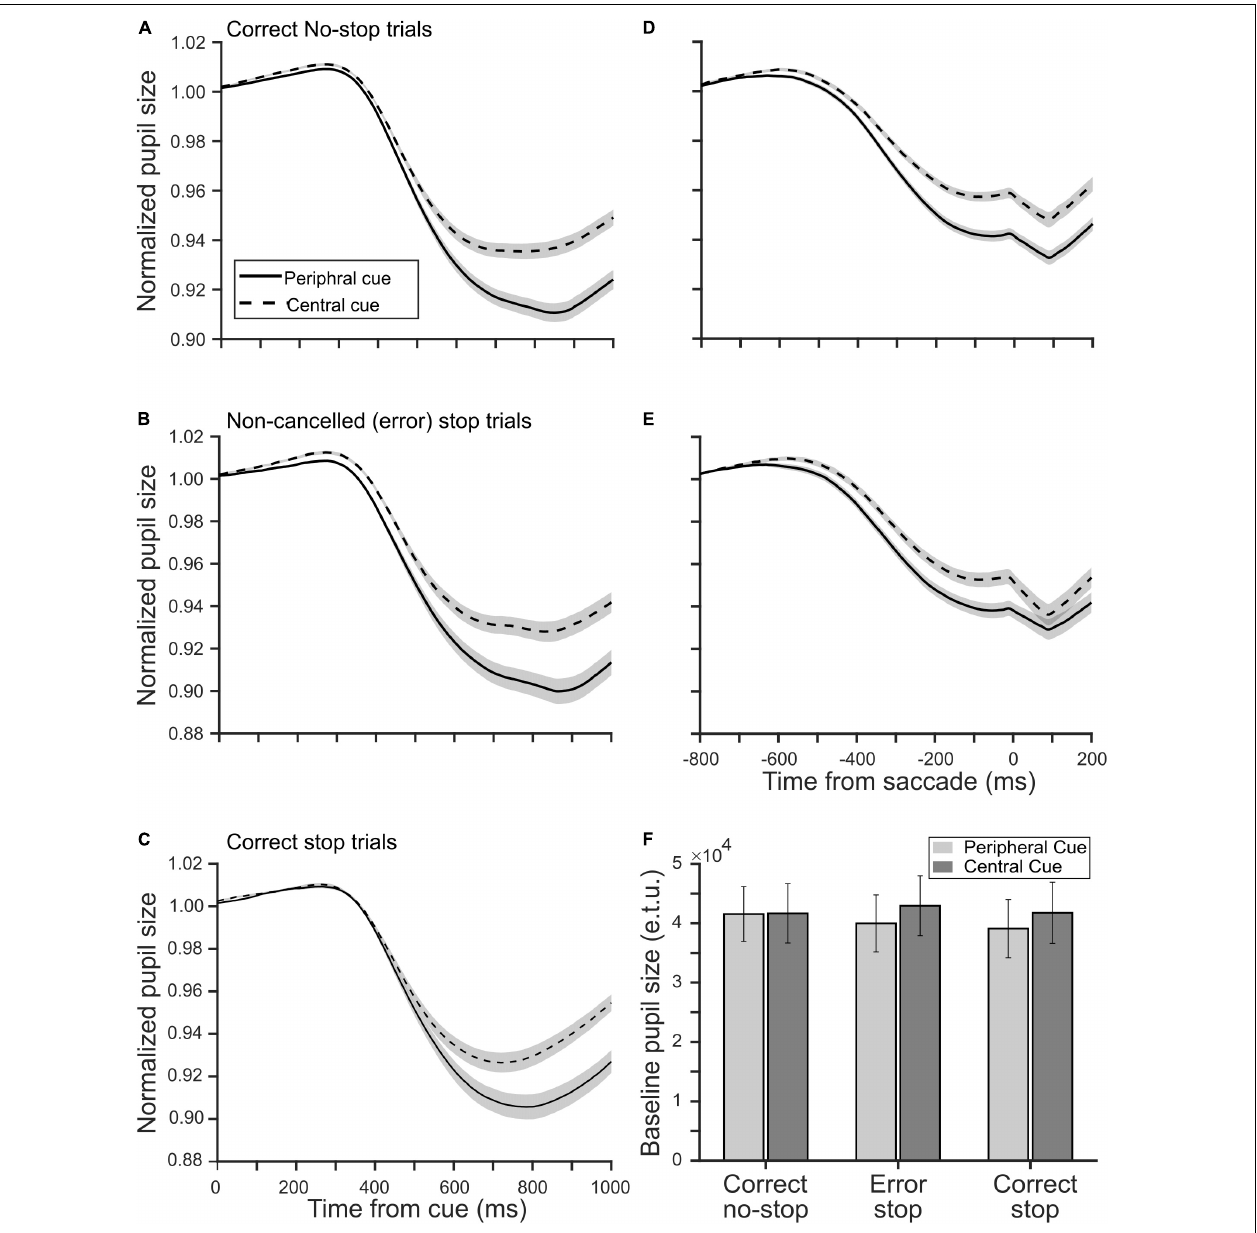
FIGURE 3 | Influence of a decision cue on the pupil dynamics relative to the cue onset (A–C) and saccade onset (D,E) in the peripheral (solid) and central (dashed) cueing task. The smoothened, normalized, and baseline-corrected pupil size averaged across trials pooled from the population of 20 participants in panels (A,D) the correct no-stop, (B,E) non-canceled stop, and (C) correct stop condition. The gray patches are overlaid on the traces to show corresponding SE of the mean pupil size. (F) The population average of tonic pre-stimulus pupil size in the eye tracker’s unit during the fixation period in correct no-stop, non-canceled stop, and correct stop trials in the peripheral (light gray) and central (dark gray) cueing task.